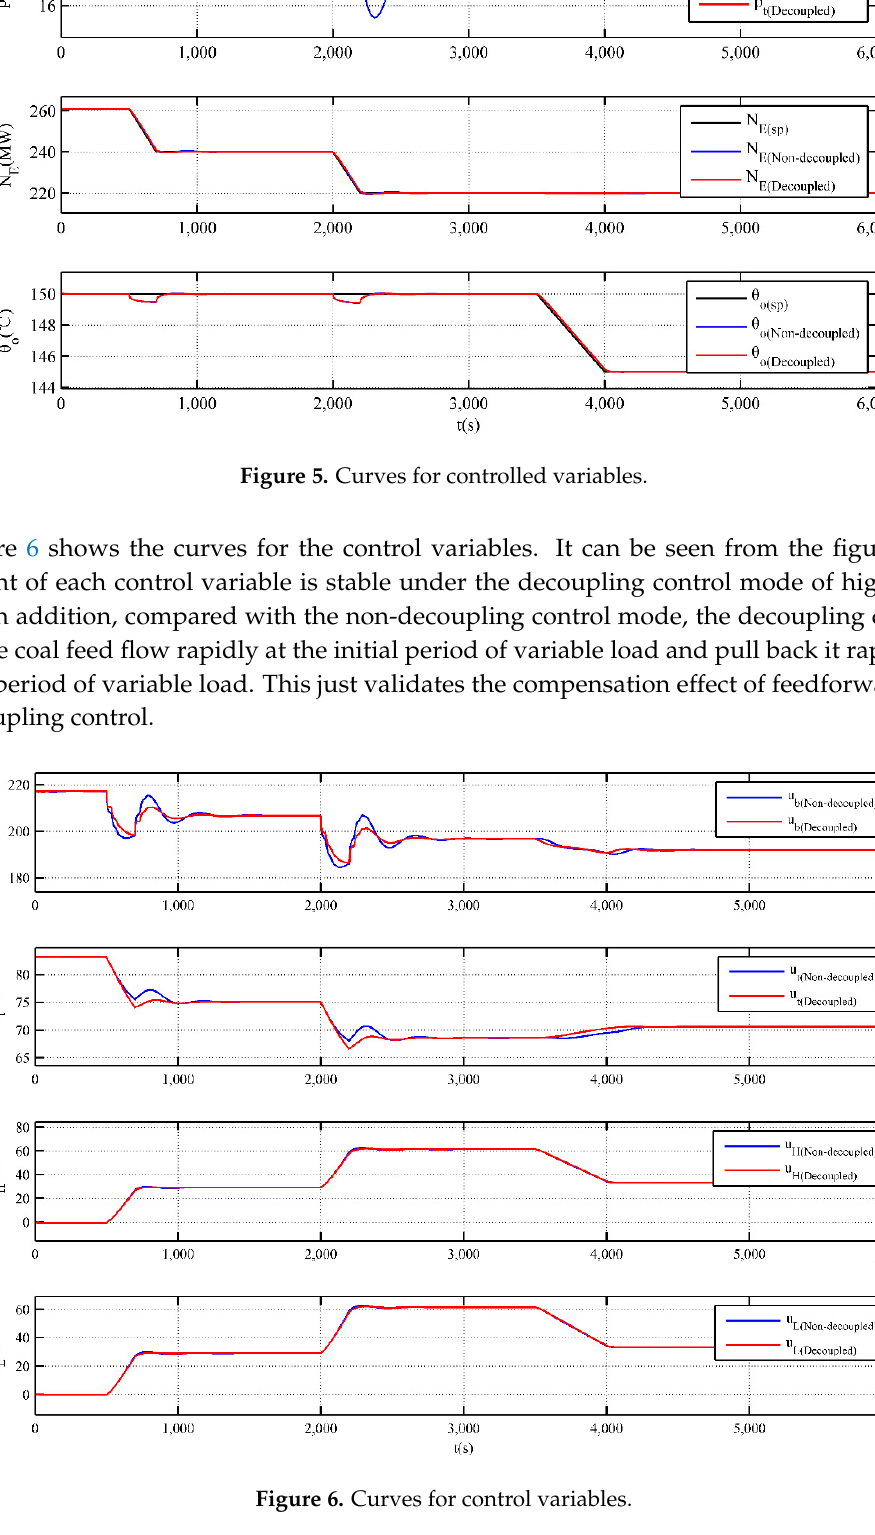
Figure 6. Curves for control variables.